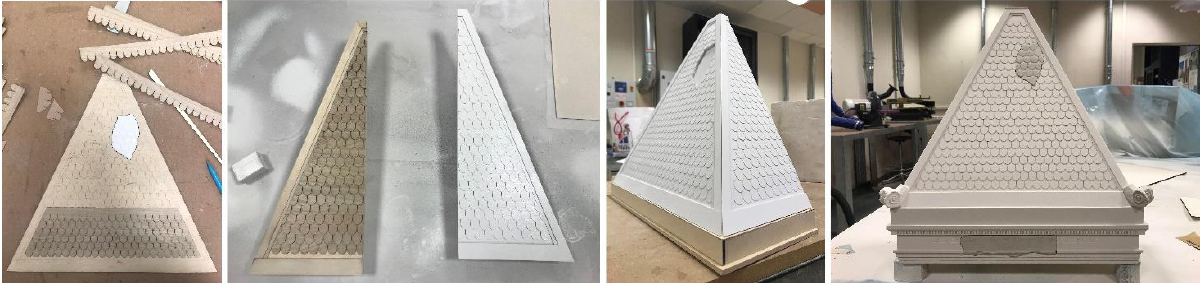
Figure 4: mounting sequence of the cusp cover (scales decoration construction, underpainting, cover assembly and final